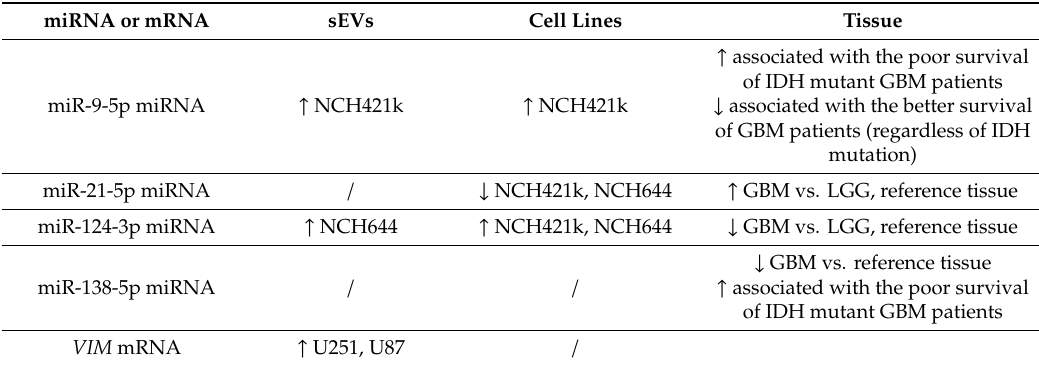
Table 6. Summary of significant results. Arrows indicate the upregulation or downregulation of specific